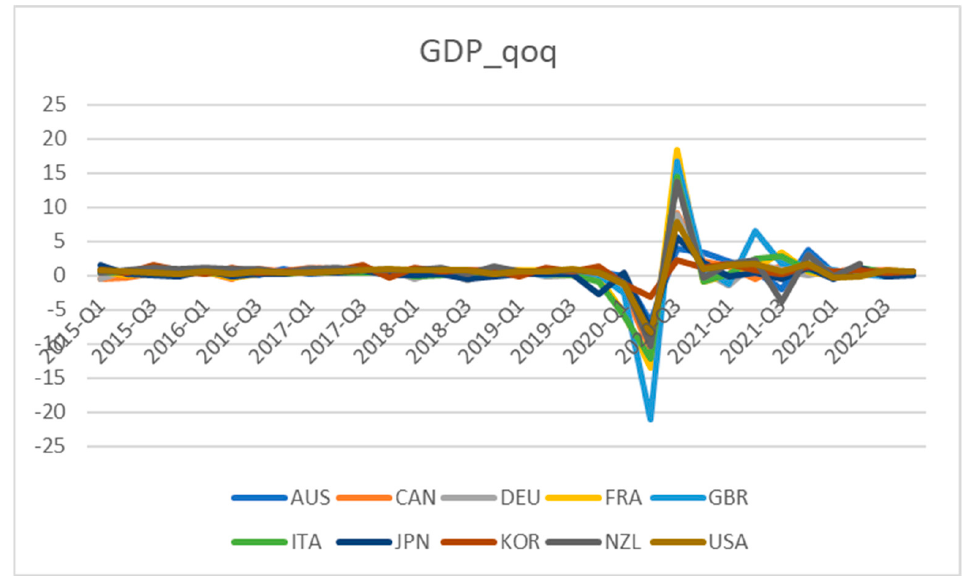
Figure 4. Quarter-on-quarter percentage change in the GDPs of ten countries from 2015 Q1 to 2022 Q3. Source: data from OECD (2022a) [36]. Legend: Australia (AUS), Canada (CAN), Germany (DEU), France (FRA), Great Britain (GBR), Italy (ITA), Japan (JAP), South Korea (KOR), New Zealand (NZL), and the United States of America (USA).